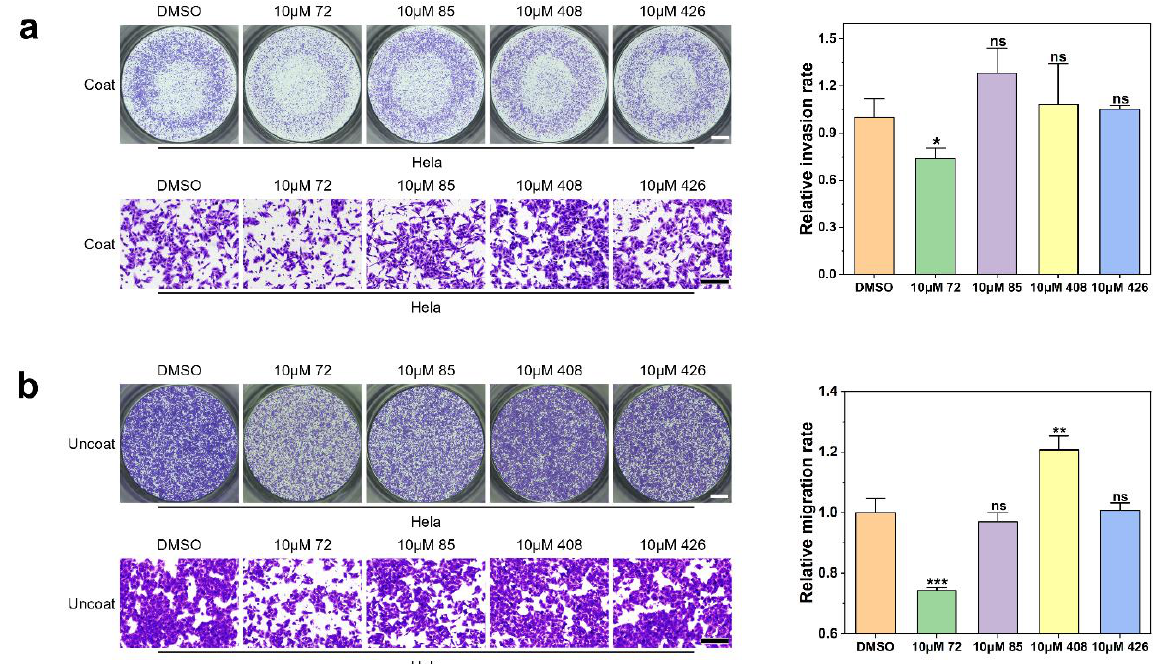
Figure 4. The effect of compound 72 , 85 , 408 , and 426 on Hela cell invasion and migration. ( a ) Invasion ability of Hela cells after treatment with different compounds for 24 h. Scale bars:1000 μm (upper left) and 200 μm (lower left). (mean ± SD, standard deviation was calculated with three replicates). ( b ) Migration ability of Hela cells after treatment with different compounds for 24 h. Scale bars: 1000 μm (upper left) and 200 μm (lower left). (mean ± SD, standard deviation was calculated with three replicates). * p < 0.05, ** p < 0.01, *** p < 0.001, ns indicates p > 0.05.